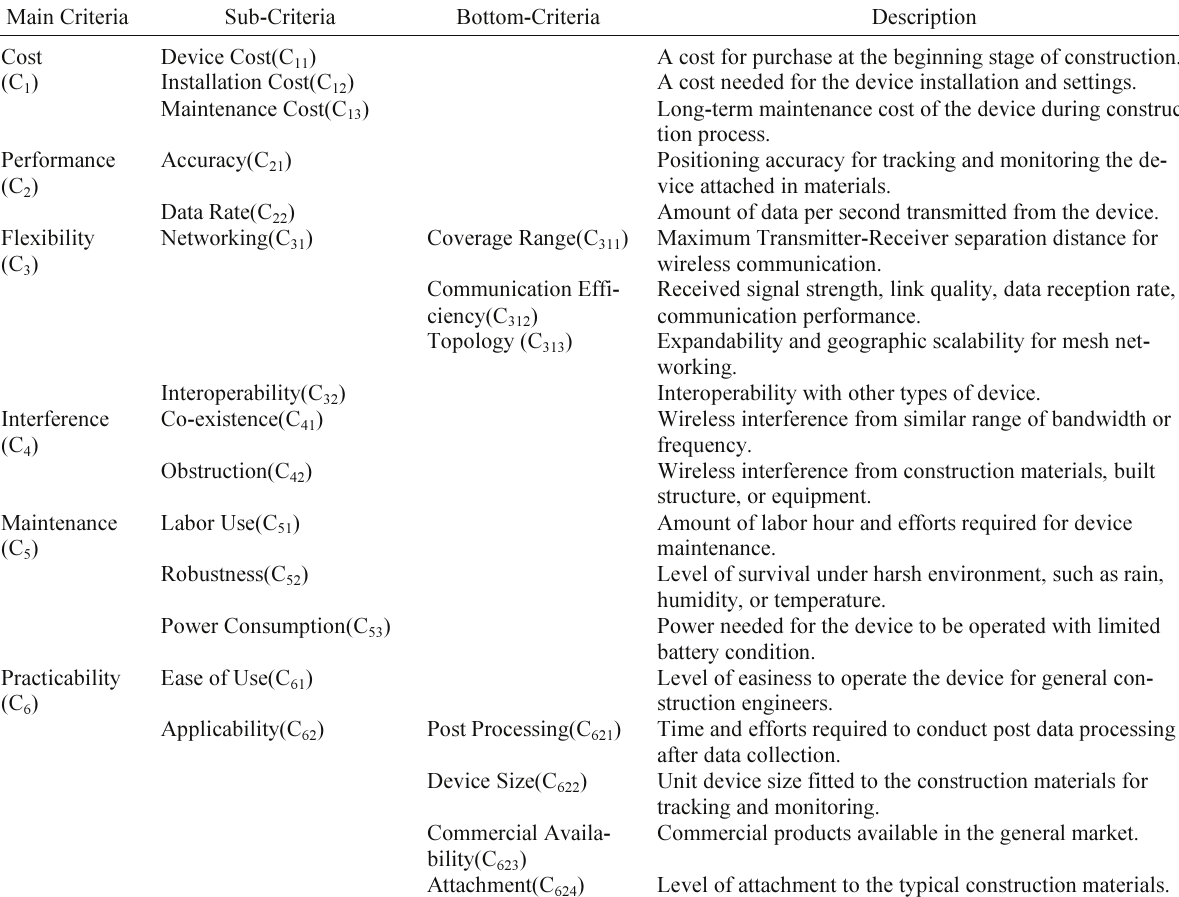
Table 2. Hierarchy of decision criteria and sub-criteria and